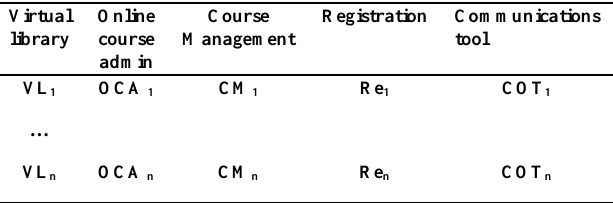
Table 1. Case study of an e-learning functional